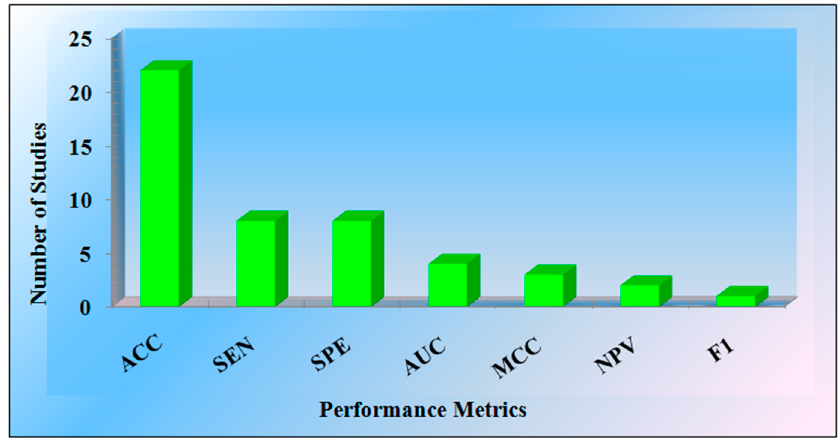
6 of 25 Figure 4. ( a ) Average accuracy of the various architectures for PD. ( b ) Minimum (red) and maxi- mum (green) accuracy of the different PD architecture (AI: Artificial Intelligence, SDL: Solo deep learning, ML: Machine learning, HDL: Hybrid deep learning).